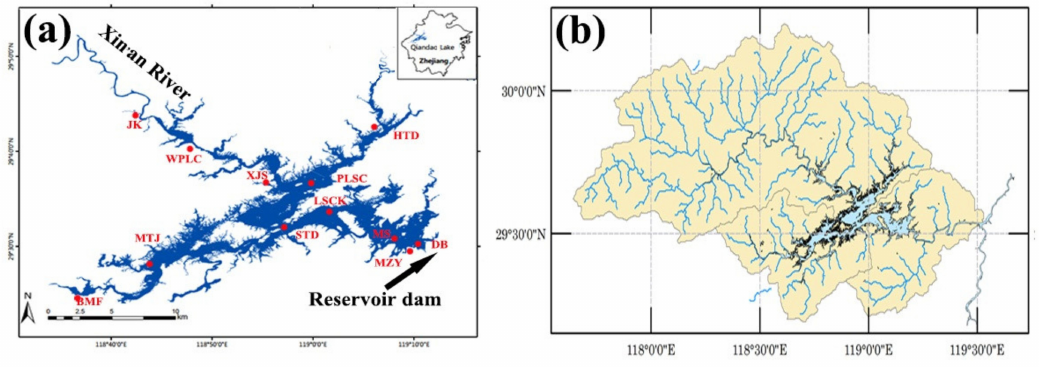
Figure 1. ( a ) Locations of the Qiandao Lake and in situ sampling stations. ( b ) Catchment region of the Qiandao Lake. Note: The lake catchment extents were identified using the WWF HydroSHEDS dataset (www.hydrosheds.org (accessed on 2 March 2021)) through the ArcGIS